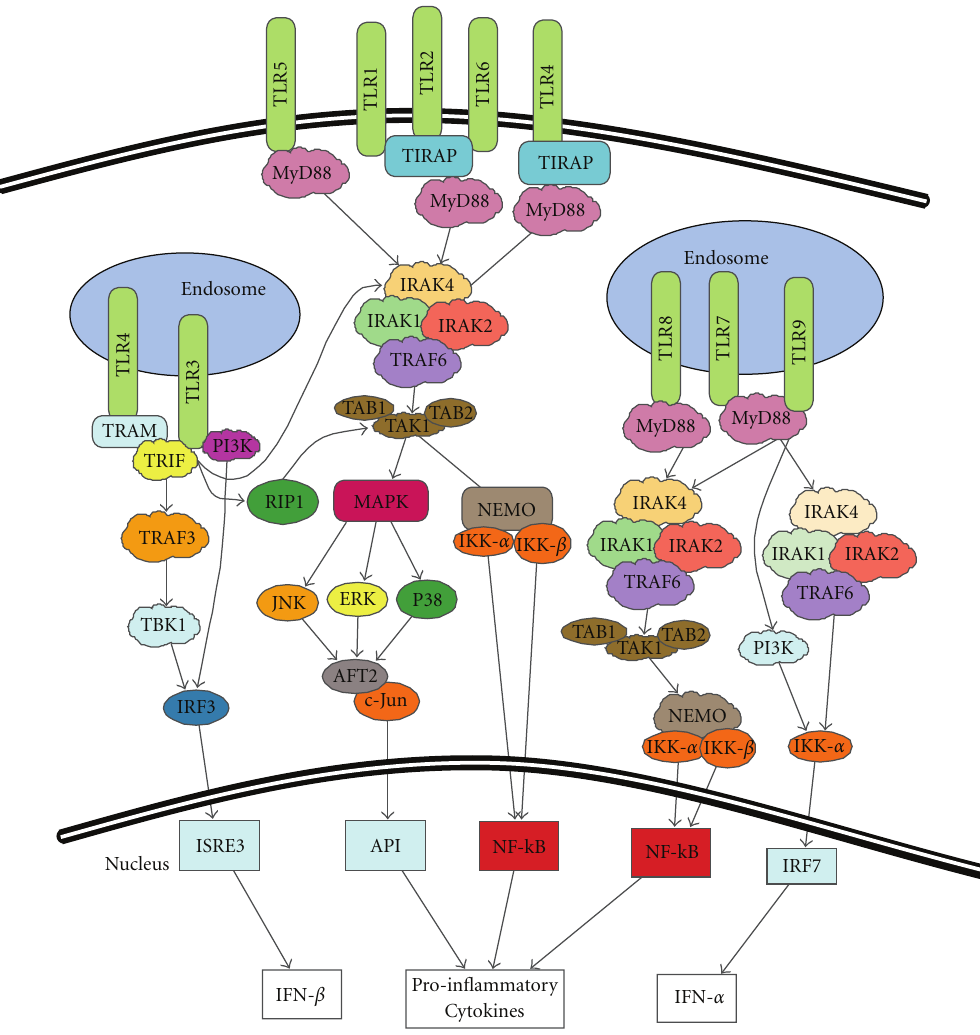
Figure 1: TLR signalling pathways: All TLRs except TLR3 share a common initial signalling pathway through MyD88 to the IRAK1/2/4TRAF6 complex. TLR3 uses TRIF to activate the IRAK1/2/4TRAF6 complex. From here, TLR1–6 are able to signal via MAPK and NEMO to activate API and NF- κ B, respectively, and promote transcription of proinflammatory cytokines. TLR8 also follows the same pattern but is only able to signal via NEMO, not MAPK. TLR7/9 are also able to activate NEMO and additionally IKK- α to promote IFN- α production. In addition to the MAPK and NEMO pathways, TLR3 is also able to signal via TRAF3 to promote IFN- β production